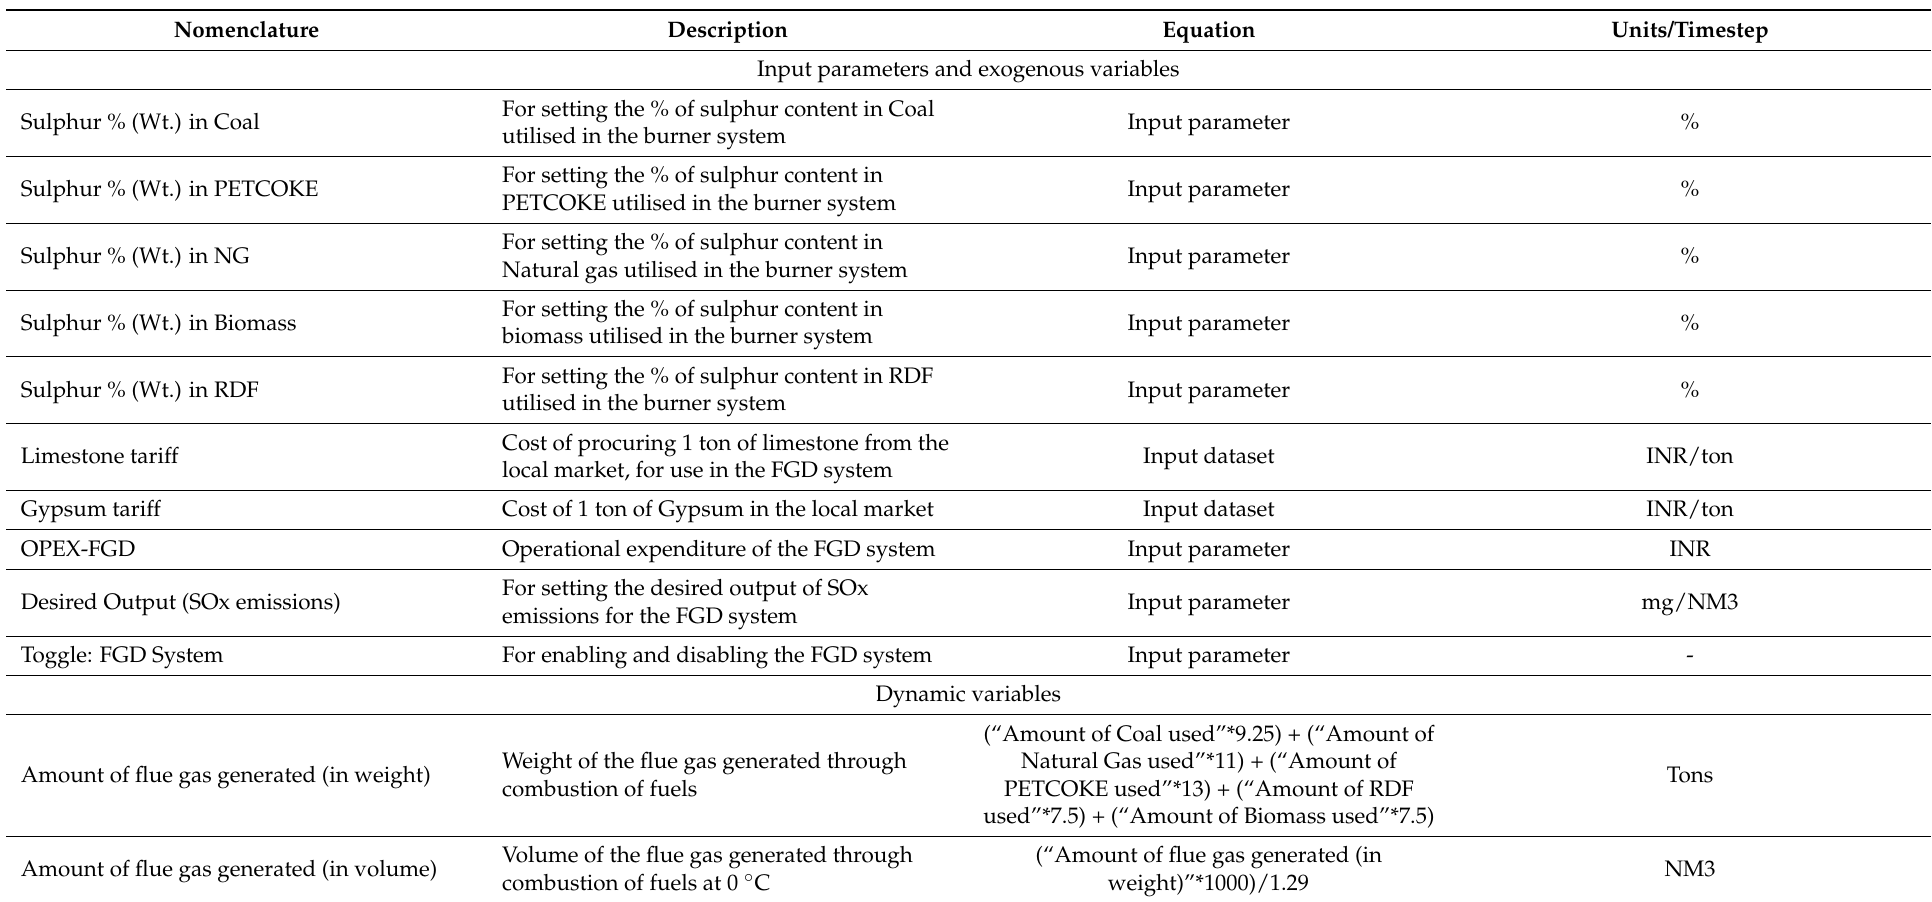
Table A2. Description of the variables used in the FGD